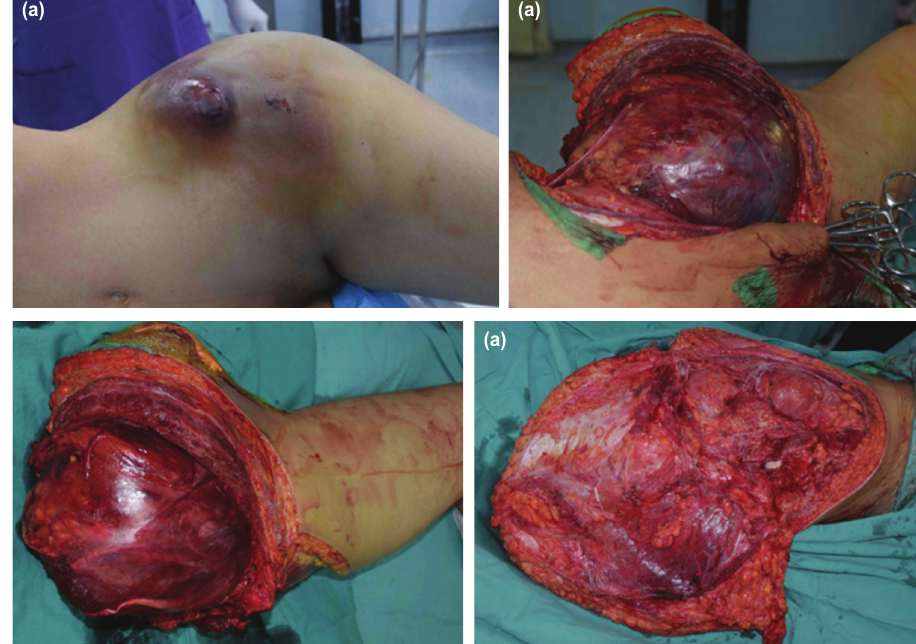
(a) Swelling at left iliac region post percutaneous sclerosing injection, (b,c) intra-operative photo showed emergency left Fig. 3: hemipelvectomy amputated with clear margin. (d) Posterior flap hemipelvectomy was